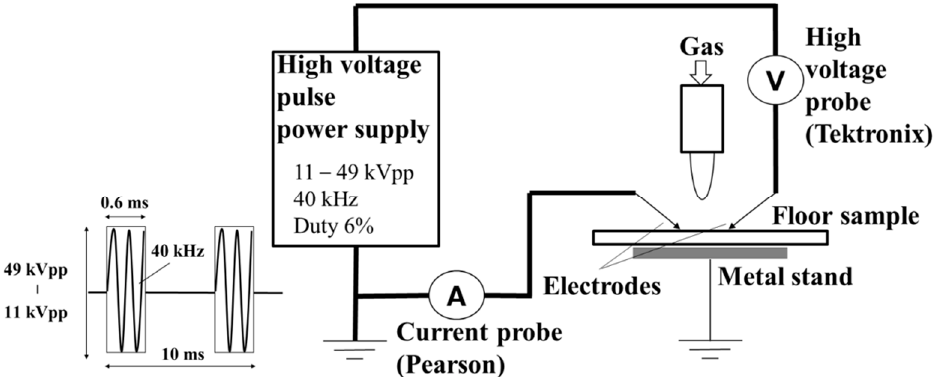
Figure 2. Schematic overview of experimental system. A high-voltage pulsed power supply is connected to the electrode. The high-voltage and current probes were used to detect the voltage and current waveforms, respectively. A sample floor tile was placed on an electrically grounded plate. The pressurized airflow was provided from tubing placed above the sample, and the flow rate was controlled by a flow meter.